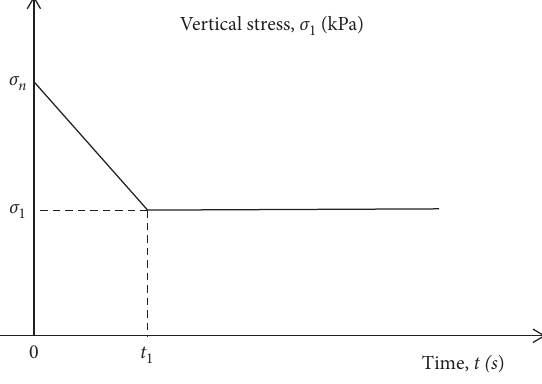
Figure 3: Load-time curve in the unloading